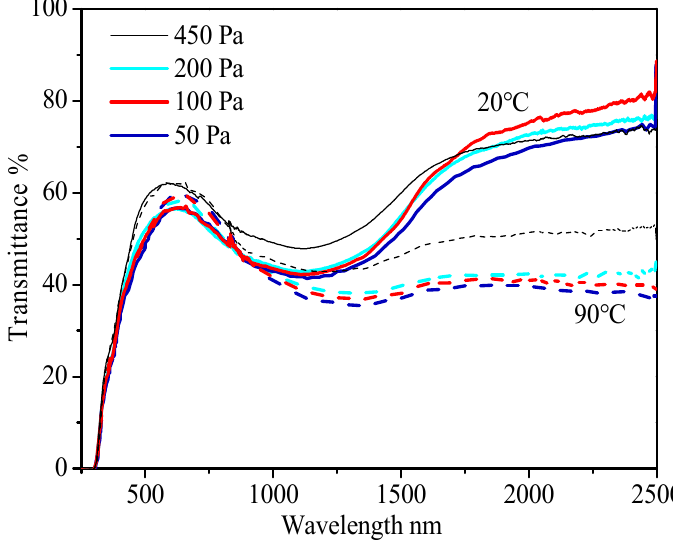
Figure 5. Transmittance of thinner VO 2 films prepared by professional annealing of 30 nm V metal films at different pressures, 400 °C for 1 h; solid line: 20 °C, dashed line: 90 °C.